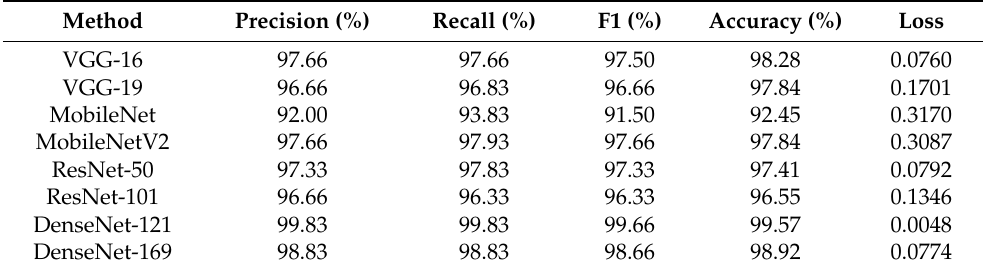
Table 5. Comparison of the testing results of automated hyperparameter tuning and automated fine-tuning for the pre-trained models. Method Precision (%) Recall (%) F1 (%) Accuracy (%)